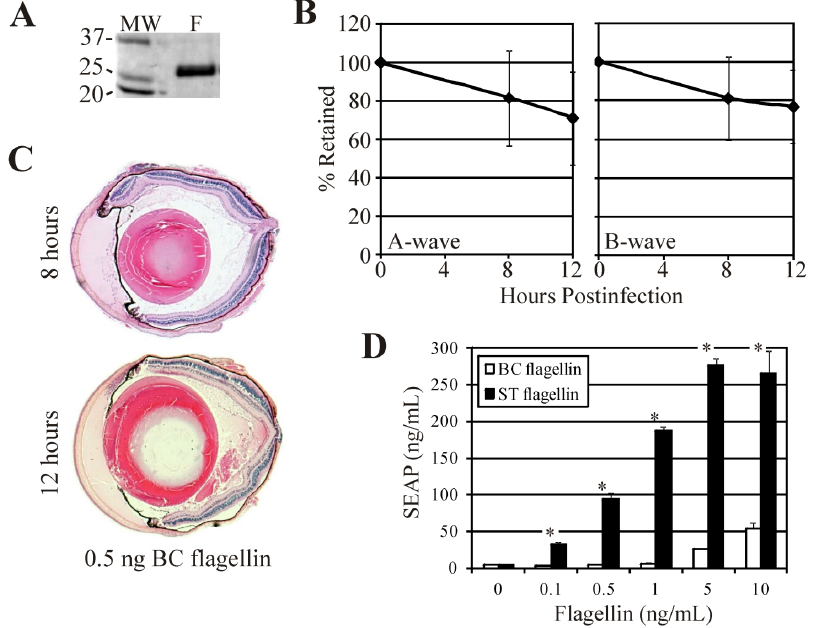
Figure 6. Role of flagellin in intraocular inflammation. A) Purified B. cereus flagellin was injected into C57BL/6J mouse eyes. B. cereus flagellin was purified as described in the Methods and analyzed for purity on a SDS-PAGE/Coomassie gel. A single band of 29 kD was recovered (lane F). B and C ) Following injection of 0.5 ng/0.5 m L of purified flagellin, eyes were analyzed by ERG and whole globe histology at 8 and 12 hours. At 8 hours, posterior segment inflammation was minimal, retinas were intact, and retinal function decreased slightly (but not significantly) from that at time 0 (Figure 6B, P $ 0.4). Compared with the significant inflammation and retinal function loss observed during infection, these results suggest that B. cereus flagellin alone may not have contributed significantly to the process. Infected eyes at 12 hours (Figure 3) demonstrated much greater pathology than that seen at 12 hours in eyes injected with flagellin alone. D ) TLR5 activation by purified B. cereus (BC) flagellin was compared with that of purified Salmonella typhimurium (ST) flagellin. B. cereus flagellin was a weak TLR5 agonist, resulting in significantly less NF k B activity at comparable flagellin concentrations (mean 6 SD for two repeated experiments, *P # 0.001).